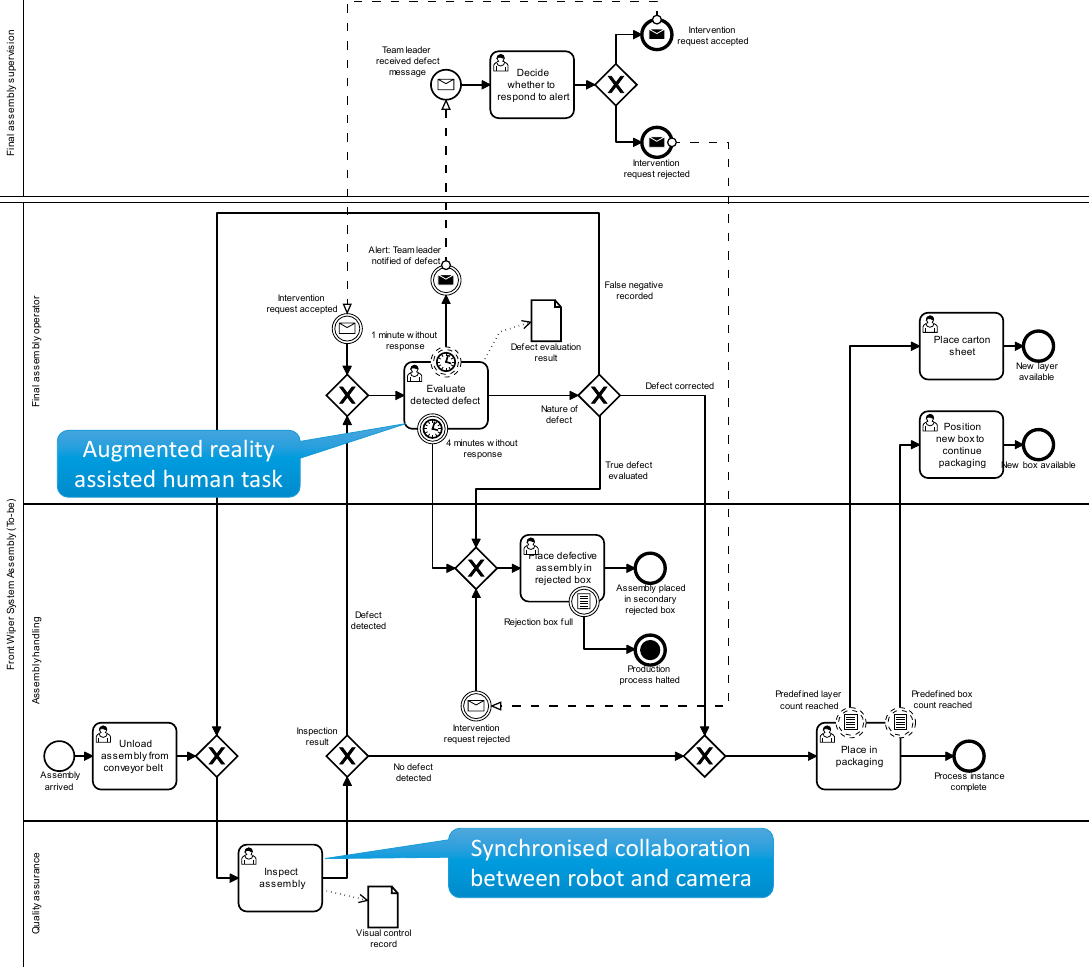
Figure 14. Assembly inspection and packaging process model of pilot case 2.